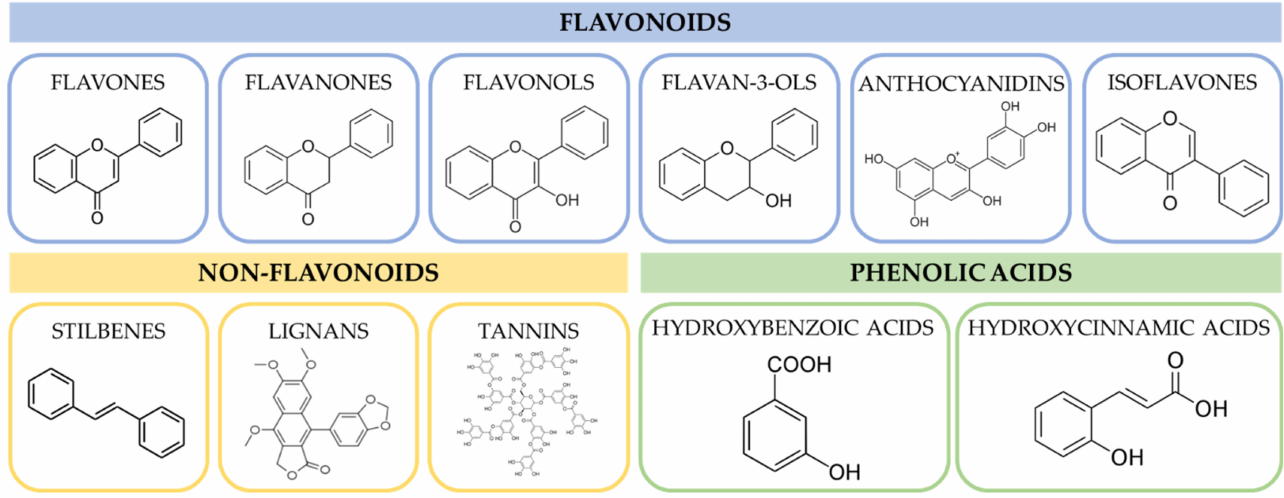
Figure 1. The classification of phenolic